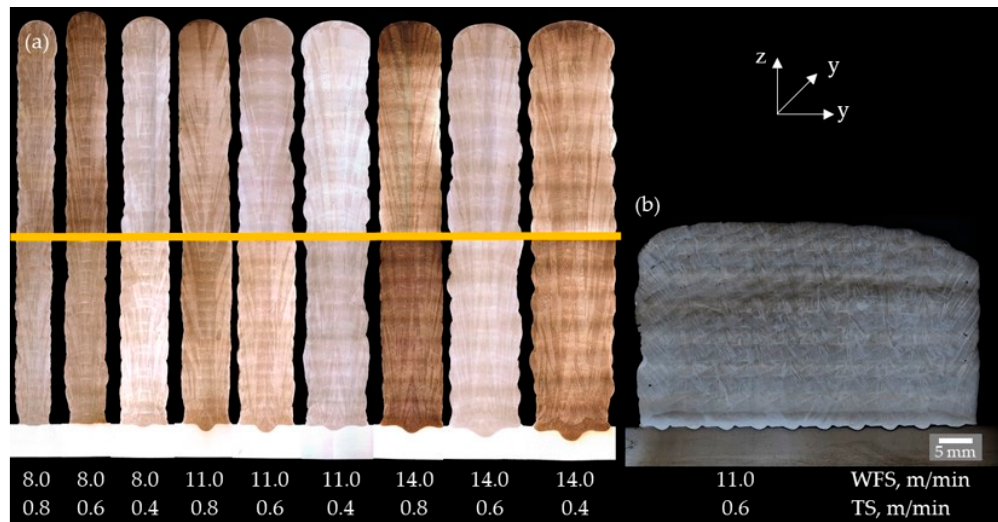
Figure 10. Macro cross sections (Y–Z plane) of walls ( a ) and block ( b ) welded with HY282 ( Φ 0.04 ″ ) depending on arc energy (etched with Beraha III).